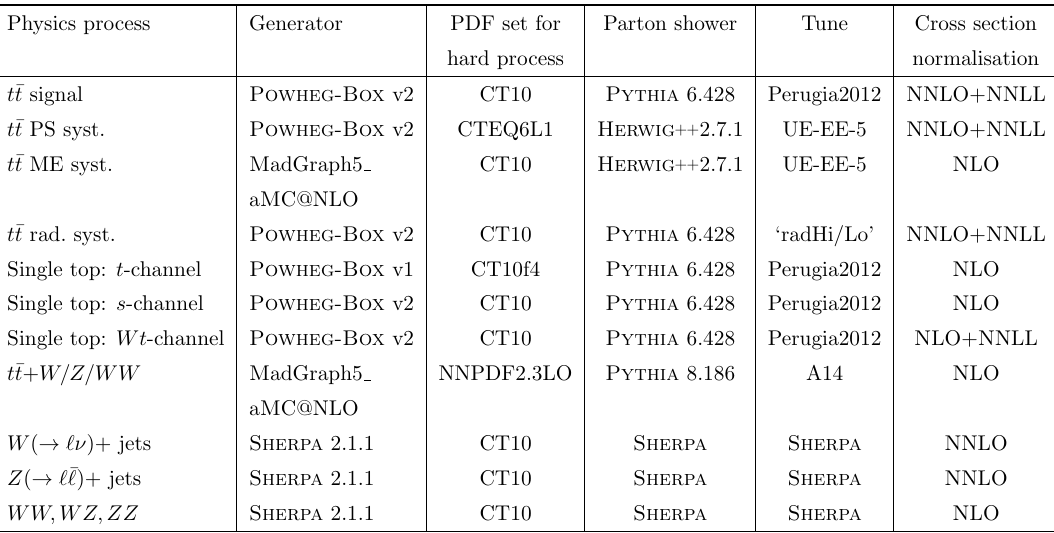
Table 1 . Summary of MC samples, showing the event generator for the hard-scattering process, cross section normalisation precision, PDF choice, as well as the parton shower generator and